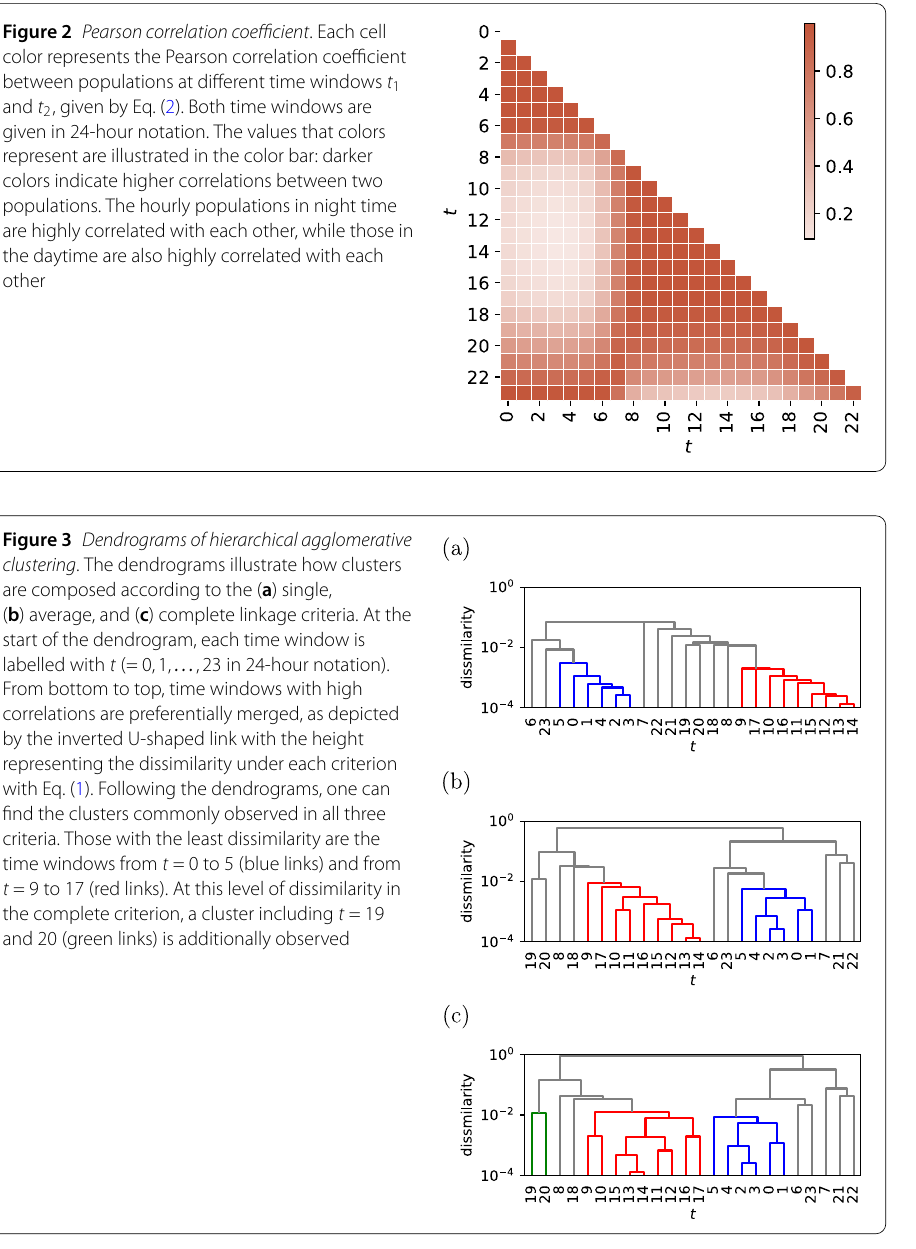
Figure 2 Pearsoncorrelationcoefficient . Each cell color represents the Pearson correlation coefficient between populations at different time windows t 1 and t 2 , given by Eq. (2). Both time windows are given in 24-hour notation. The values that colors represent are illustrated in the color bar: darker colors indicate higher correlations between two populations. The hourly populations in night time are highly correlated with each other, while those in the daytime are also highly correlated with each other